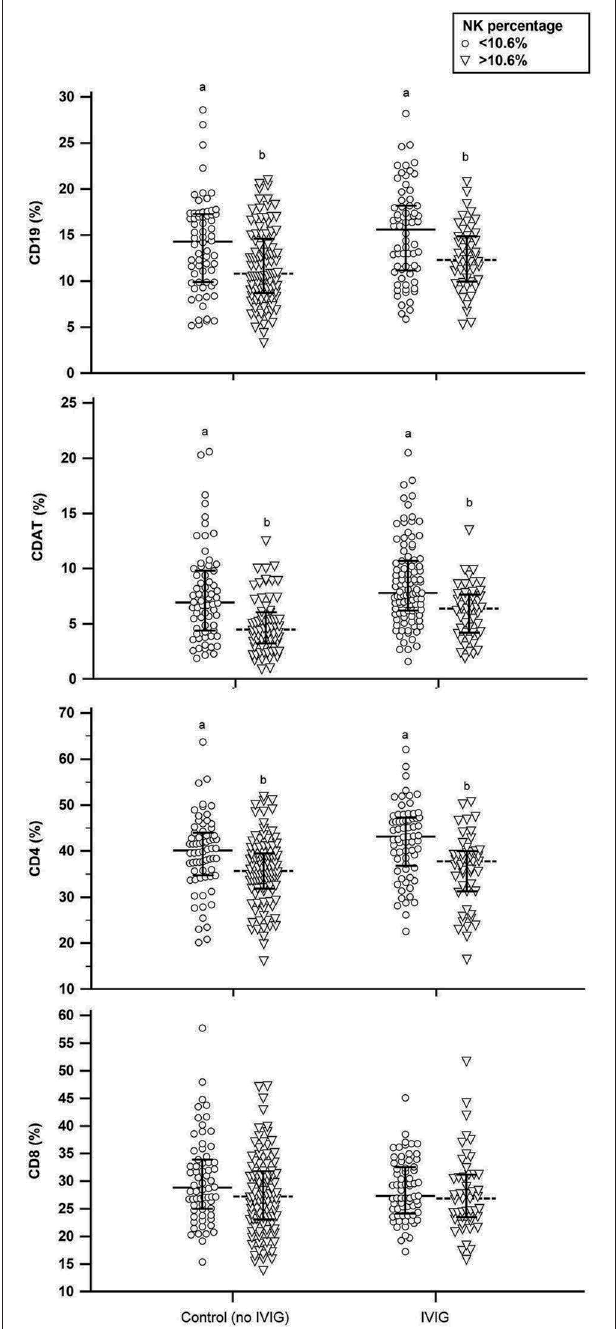
FIGURE 4 | The distribution of peripheral mononuclear cell profiles between high and low percentage of CD56 + CD16 + NK cells in intravenous immunoglobulin (IVIG) and non-IVIG groups. Different letters in the same subset figure indicate a significant difference, P < 0.01, using Mann-Whitney U